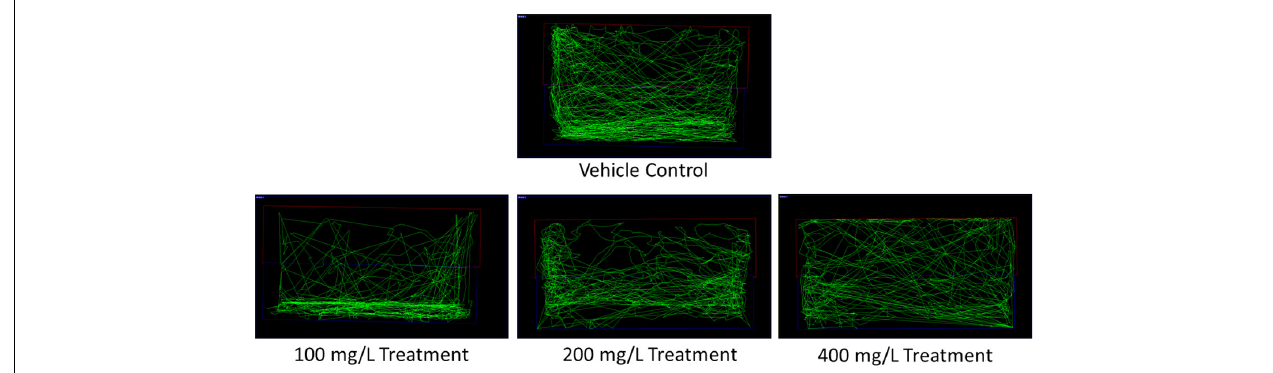
FIGURE 1 | Representative zebrafish swimming pattern of the vehicle control and extract treated groups for the toxicity study.